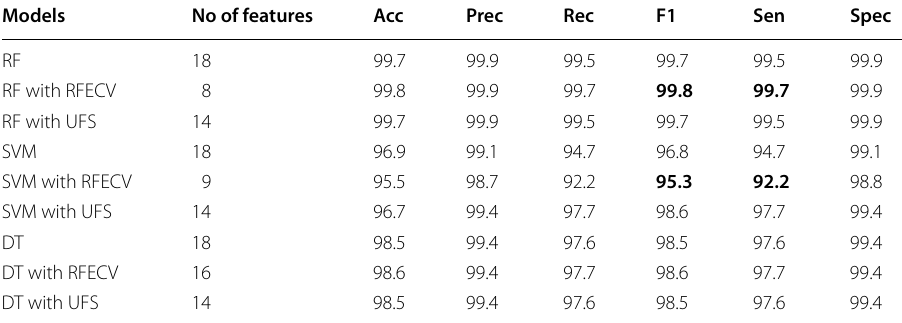
Table 5 Binary classification without and with feature selection Models